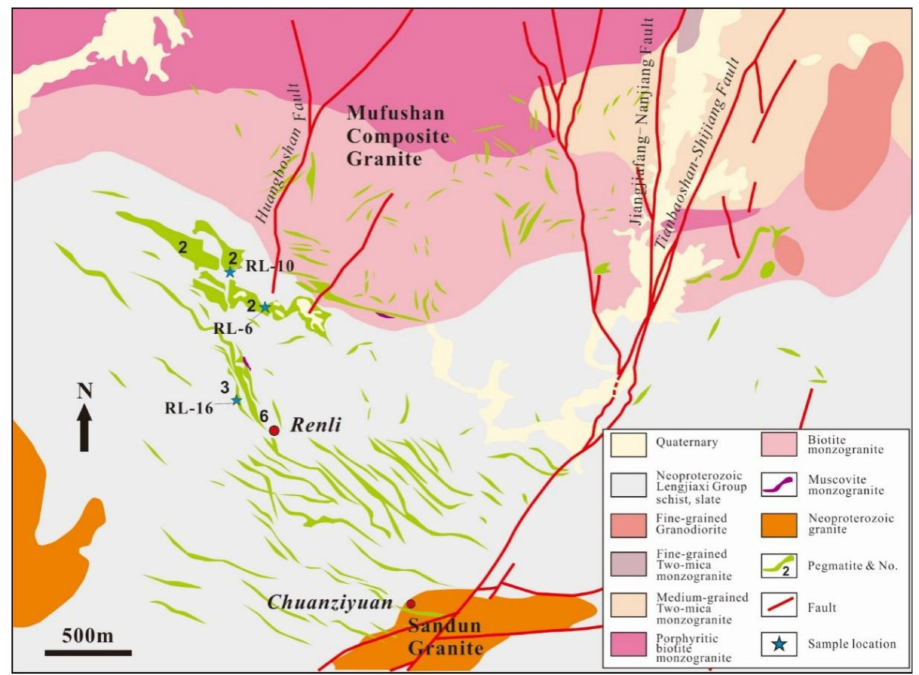
Figure 2. Geological map of the Renli Nb-Ta deposit (modified after [14]). RL is the abbreviation for